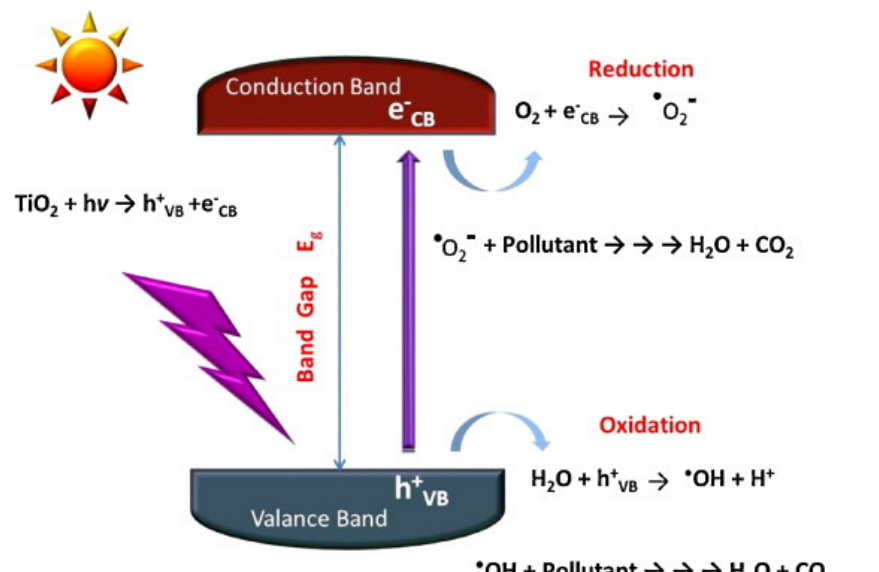
Figure 2. Mechanism of TiO 2 photocatalysis [23].